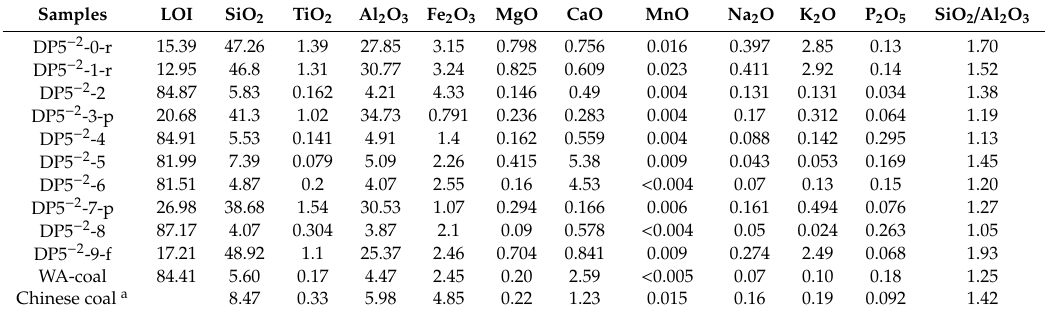
Table 4. Concentrations of major element oxides (%) in the coal benches, partings, roofs, and floor samples from Dongpo